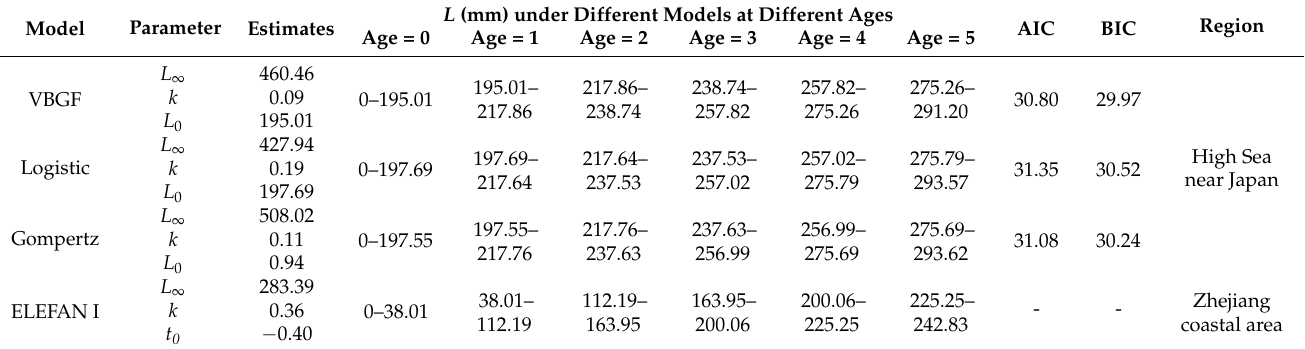
Table 5. Estimates of growth parameters for Chub mackerel in the northwest Pacific Ocean from different growth models fitted to length-at-age data and ELEFAN I in waters off Zhejiang coast.